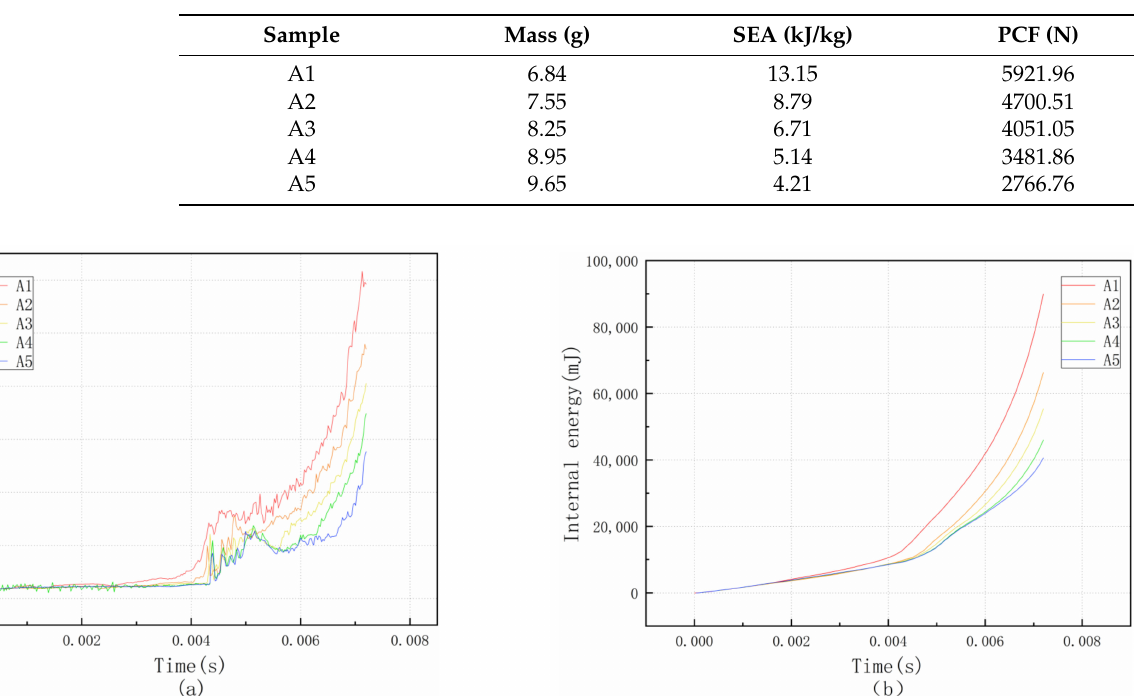
Figure 12. Cellular structures of different sizes of S . Table 2. Numerical results of specimens with different sizes of S .